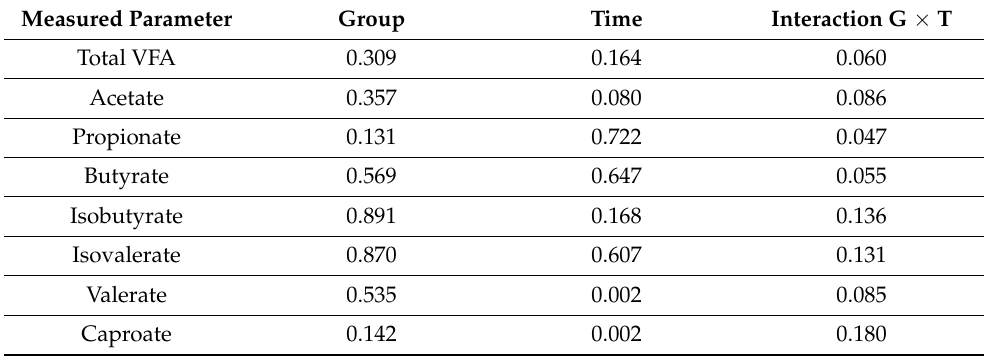
Table 1. p -values associated with the VFA statistical analysis with a linear mixed model.